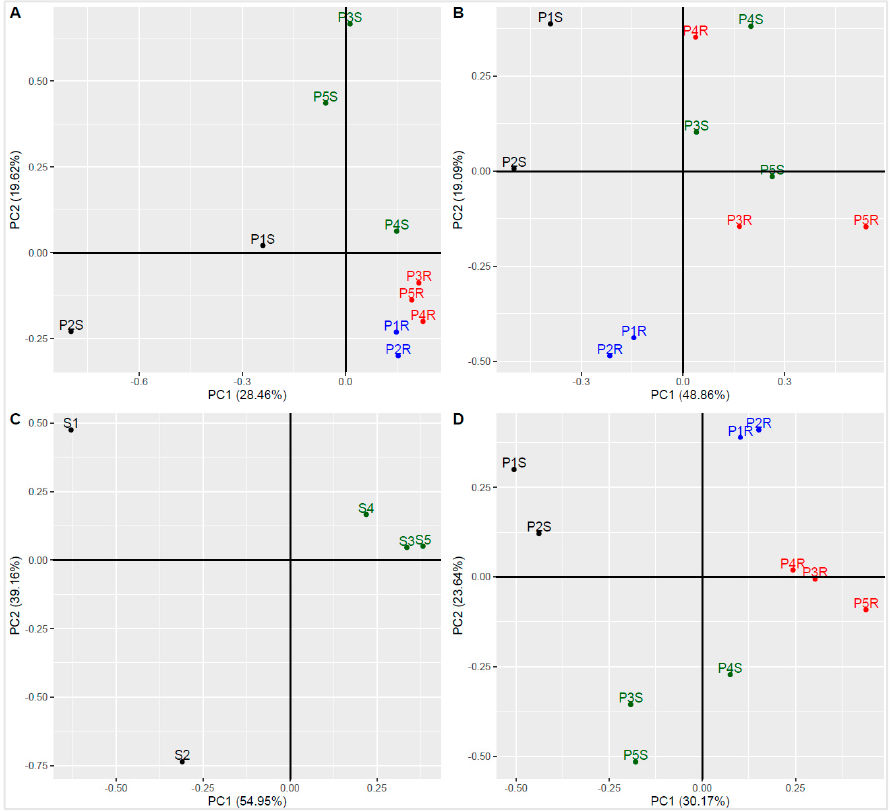
Figure 6. Principal component analysis (PCA) of biological and chemical data. ( A )—PCA based on percentage contribution of bacterial sequences identified on a family-rank level. ( B )—PCA based on normalized responses obtained for bacterial communities by the Biolog Ecoplate method. ( C )—PCA based on soil chemical data. ( D )—PCA based on a combination of family-rank bacterial sequence percentile contribution and normalized community responses on Biolog Ecoplates.